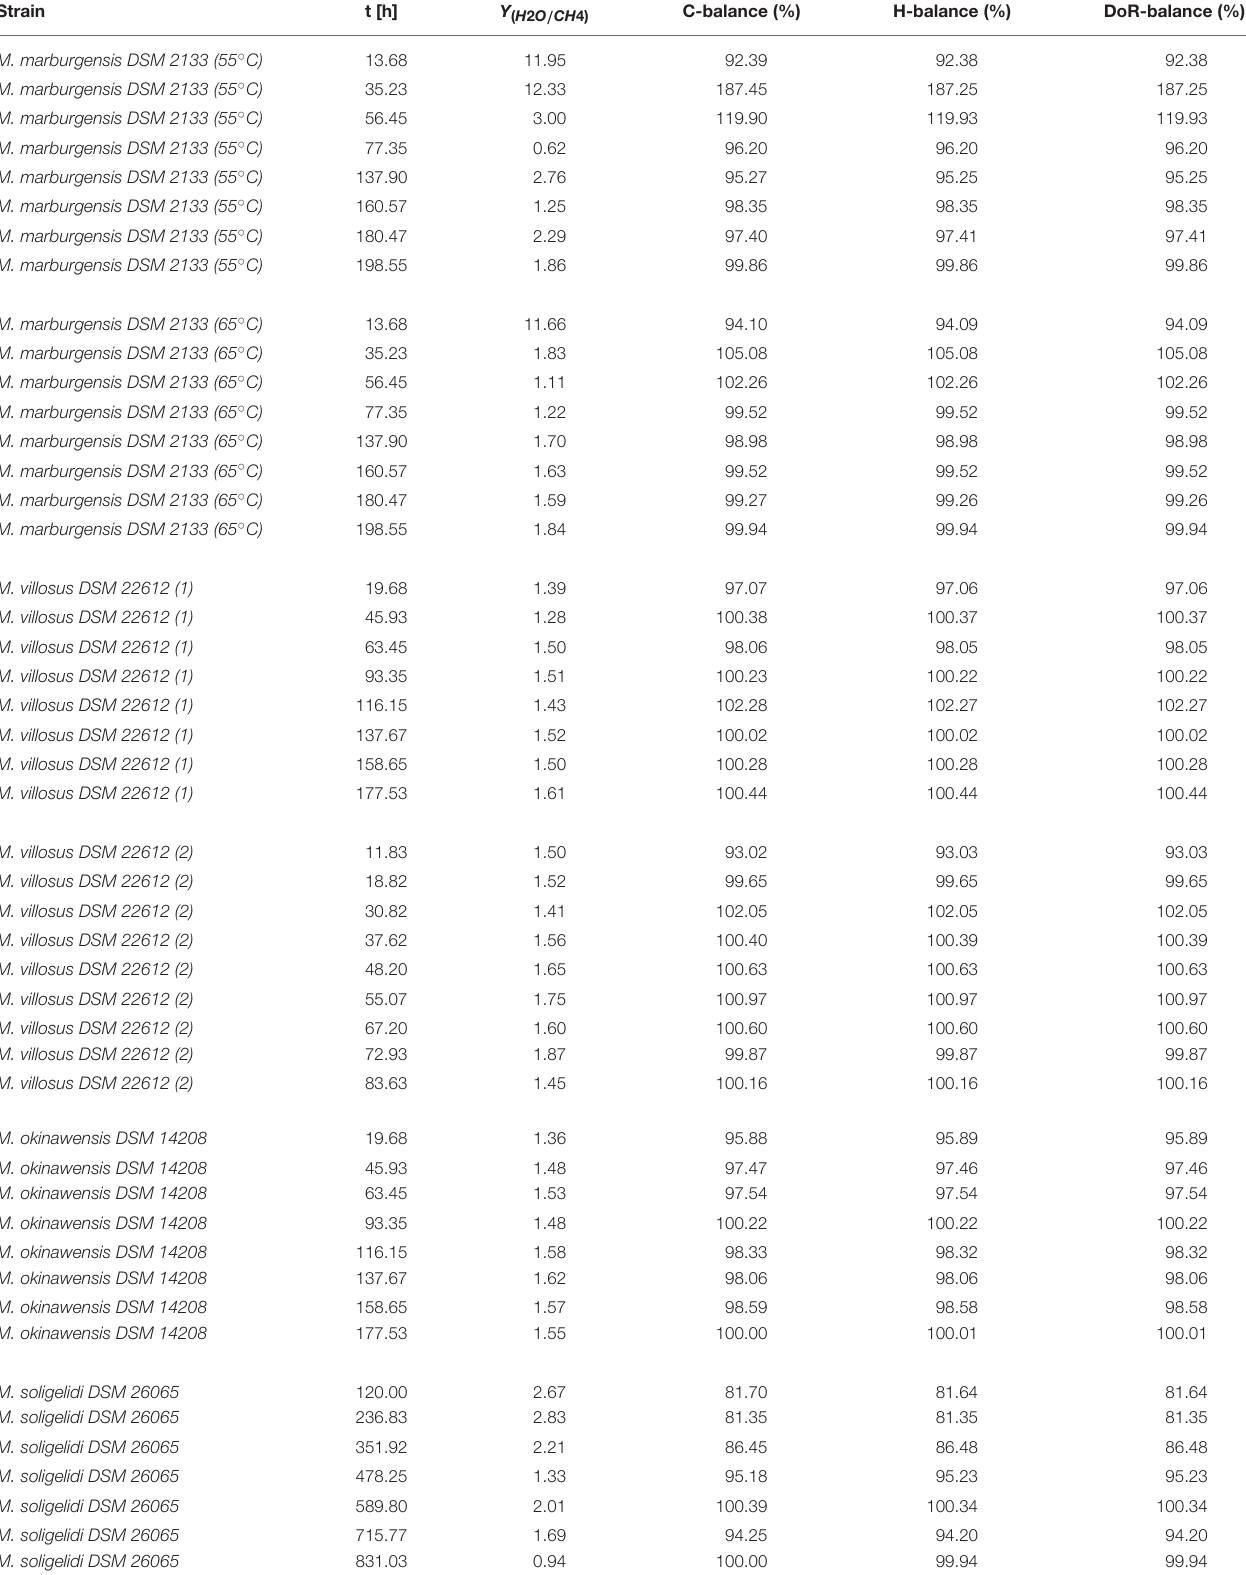
TABLE 2 | Mass balances of the different experiments without OD measurements.